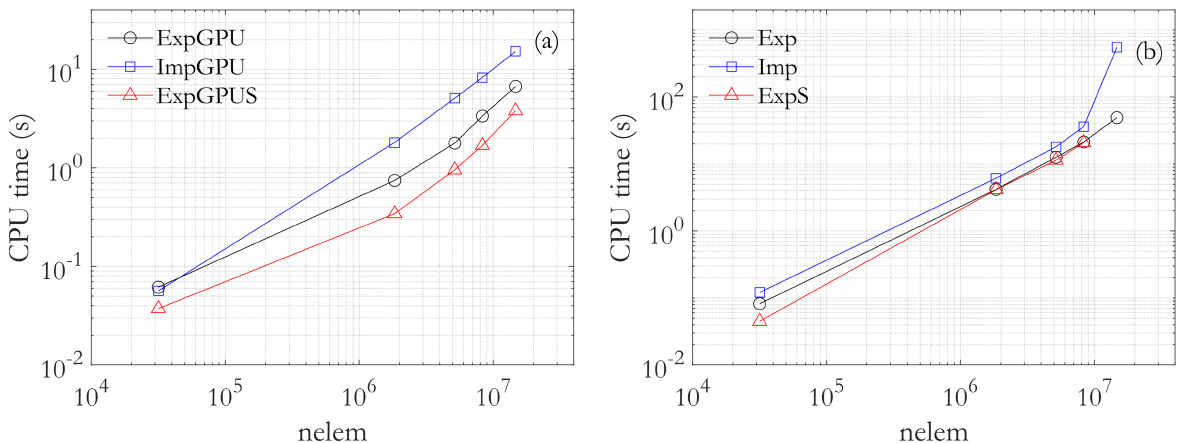
Figure 9. Build time of local stiffness matrices that (a) on the GPU (b) on the